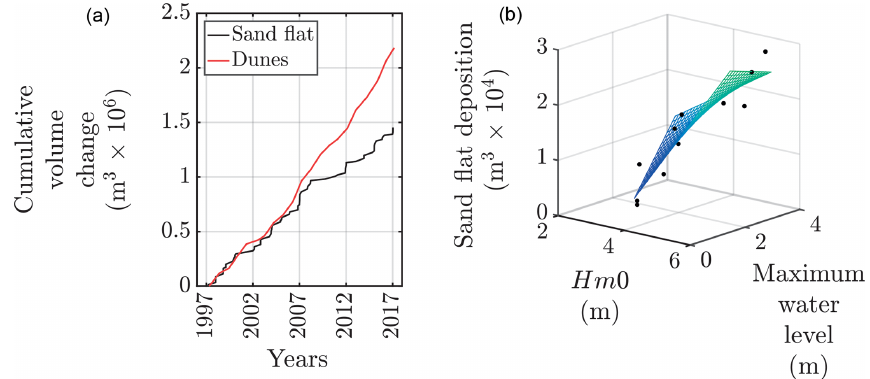
Figure 14. (a) Cumulative volume changes from the dunes using lidar data (dunes) and estimated sand flat deposition using regression model as predictor (sand flat). The regression model has been built using simulation results with maximum water level at the boundary and wave height as predictors for deposition. (b) Scatter plot of the regression model used with regression